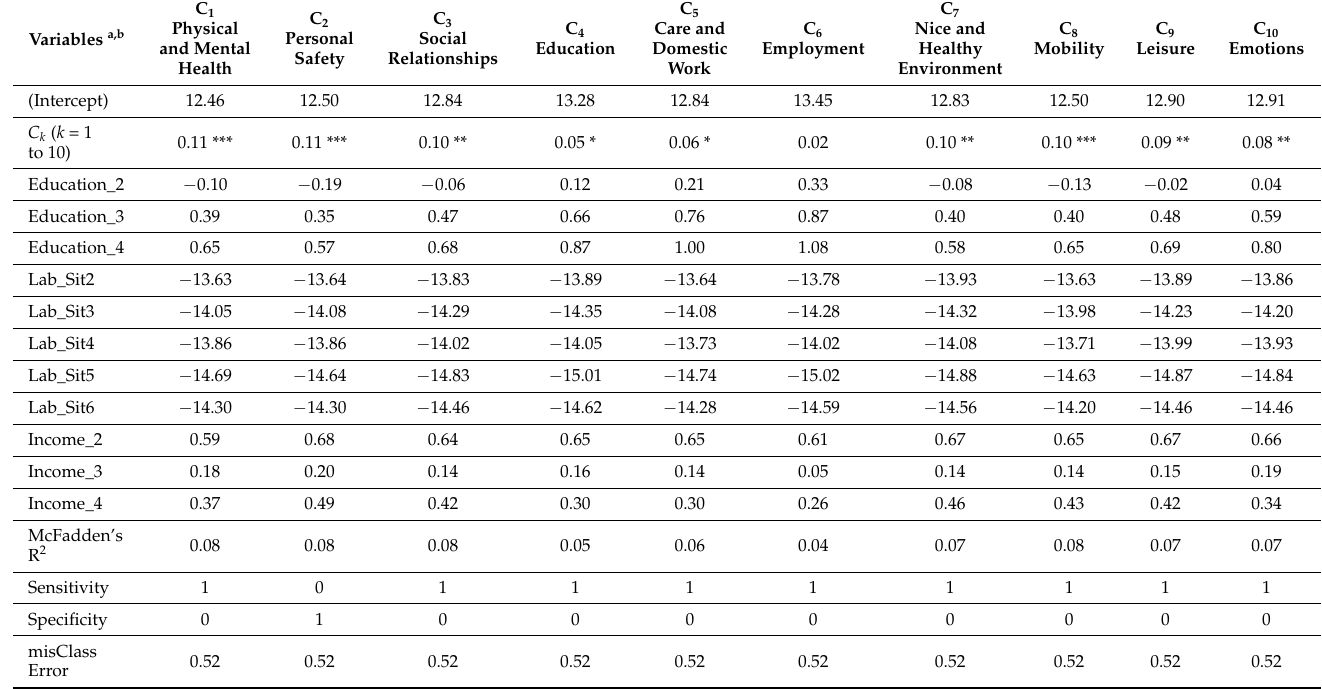
Table A7. Significance of coefficients of regressions with different capabilities. Men and age 40 to